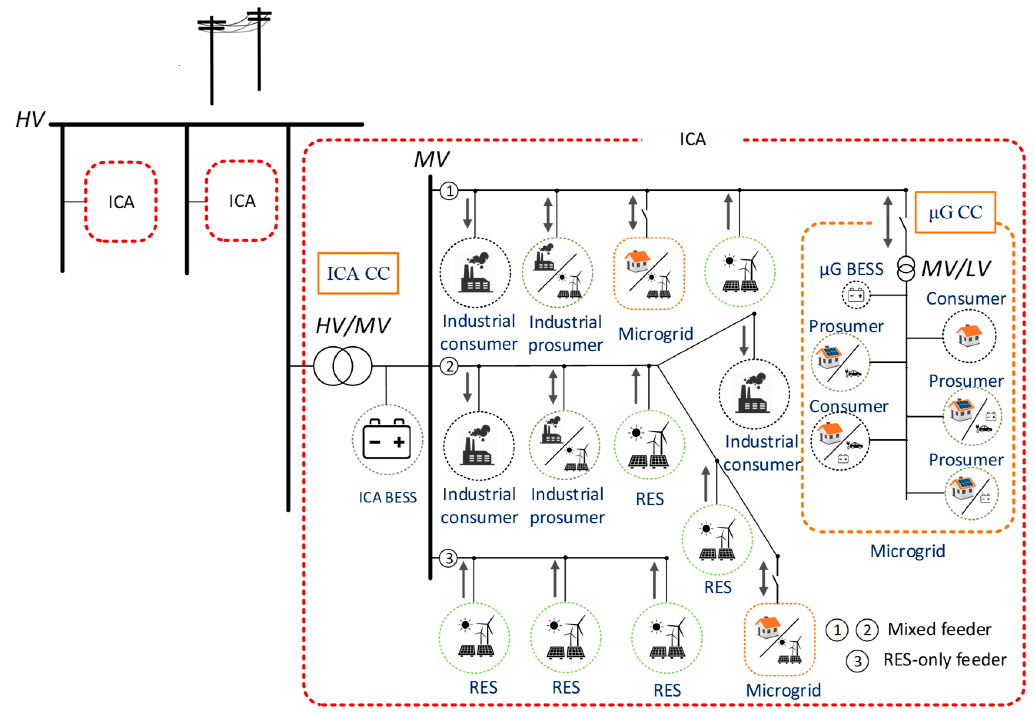
Figure 1. General representation of a distribution grid (ICA) .